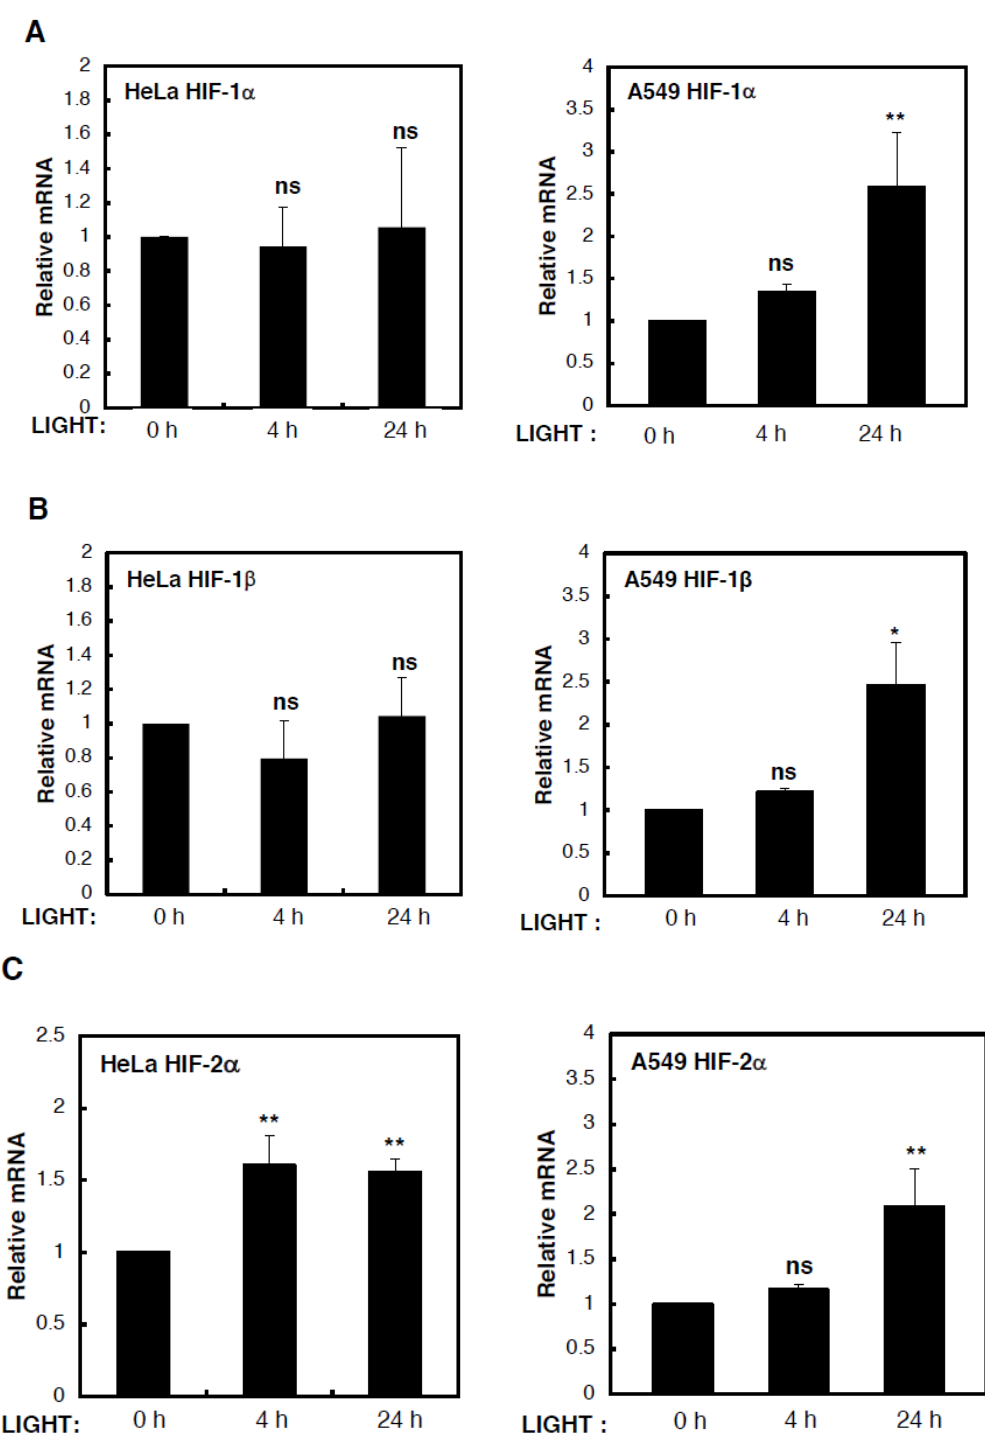
Figure 2. LIGHT induces the expression of HIF-2 α mRNA. mRNA was extracted from HeLa and A549 cells, previously treated with 100 ng/mL LIGHT for 0, 4 and 24 h, and RT-qPCR analysis was performed for ( A ) HIF-1 α , ( B ) HIF-1 β , and ( C ) HIF-2 α , normalising to Actin mRNA levels. All the values were normalised to the untreated samples. All graphs indicate mean and SEM determined from at least three independent biological experiments. One way Anova analysis was performed and significance determined as follows: ns = not significant, * p ≤ 0.05, ** p ≤ 0.01.